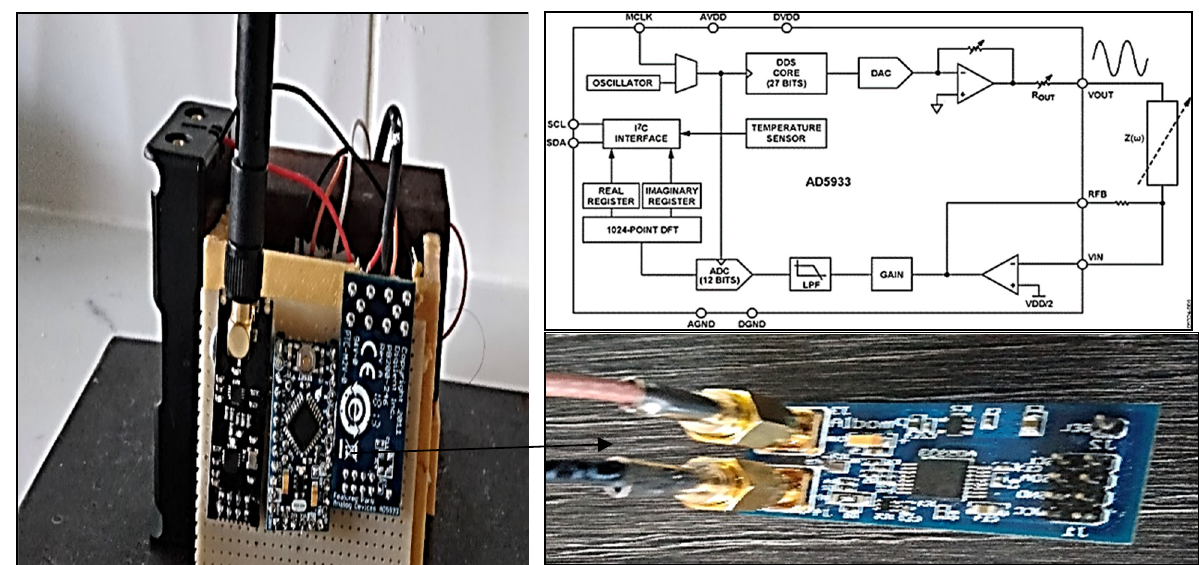
Figure 12. ( a ) The magnetization unit of the MEC sensor, and ( b ) the gateway for communication with the data cloud.